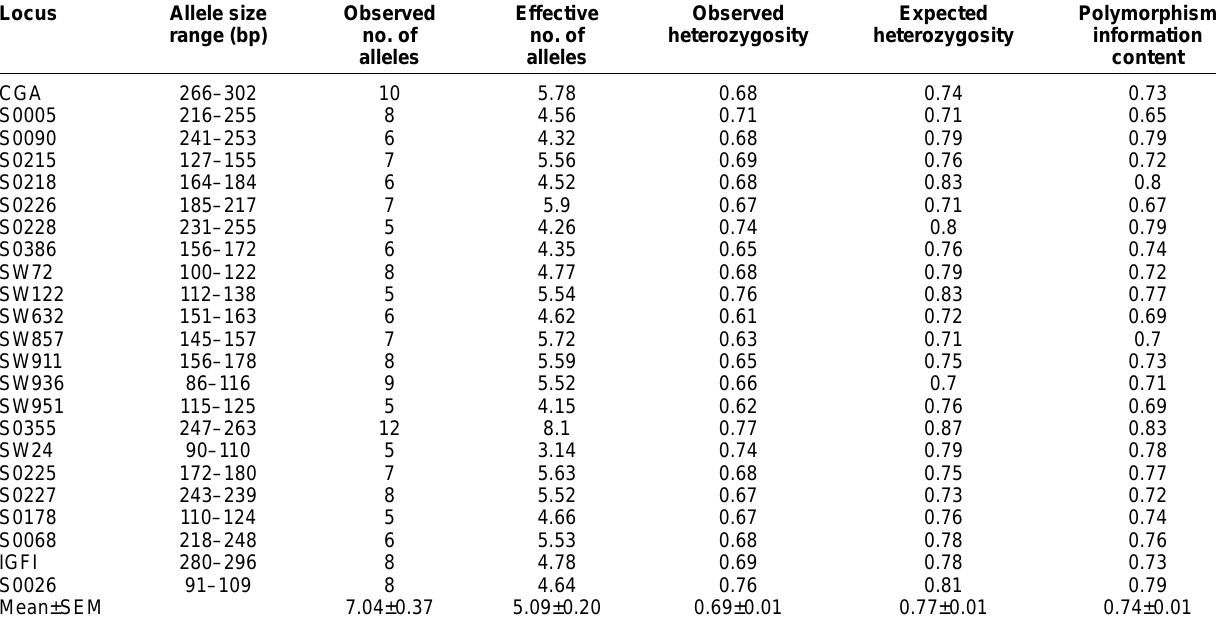
Table-1. Observed and effective number of alleles, observed and expected heterozygosity and polymorphic information content in 23 FAO-recommended microsatellite loci in Andaman Desi pig